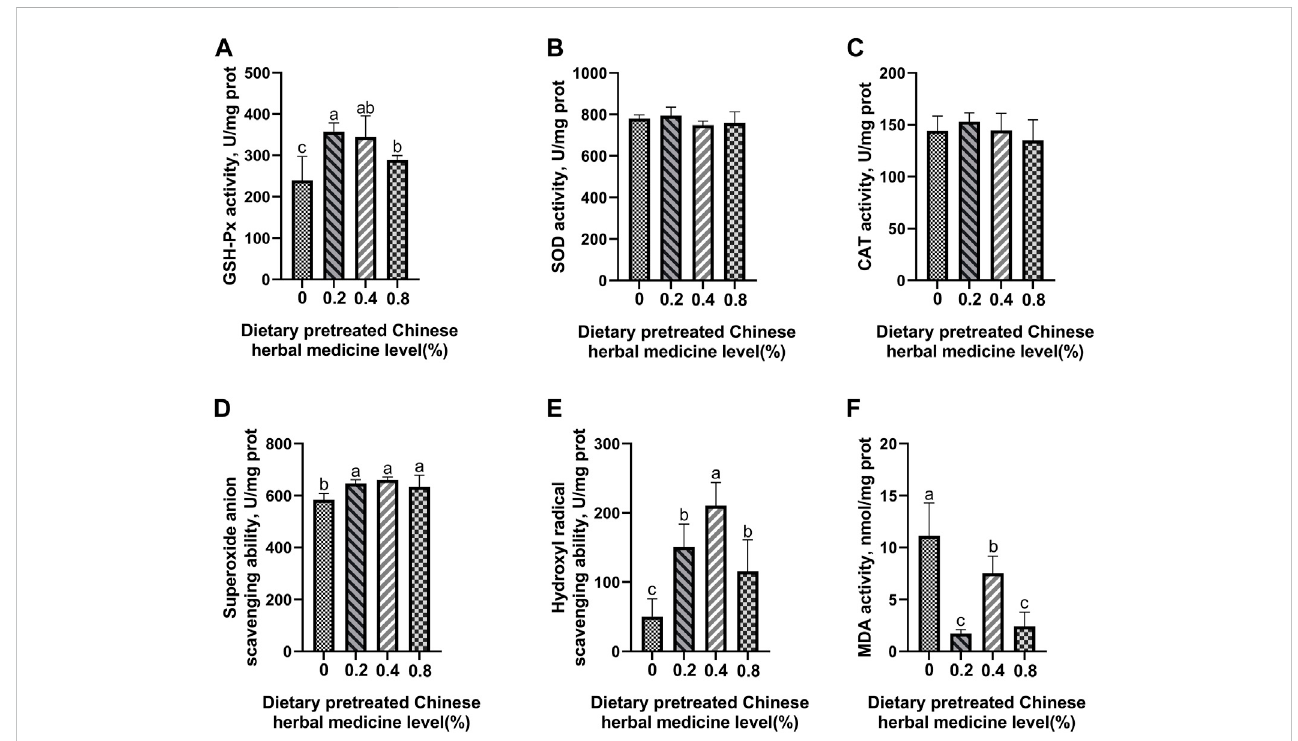
FIGURE 3 Effect of dietary PCHM supplementation on the antioxidant enzyme activity and free radicals in the liver of late-phase laying hens. (A – C) Glutathione peroxidase(GSH-Px),superoxidedismutase(SOD),andcatalase(CAT)activityintheliver. (D,E) Scavengingfreeradicalabilitiesintheliver. (F) Malondialdehyde (MDA) level in the liver. Values are expressed as means ± SEM of six birds per treatment. Means without a common letter differ ( p < 0.05).